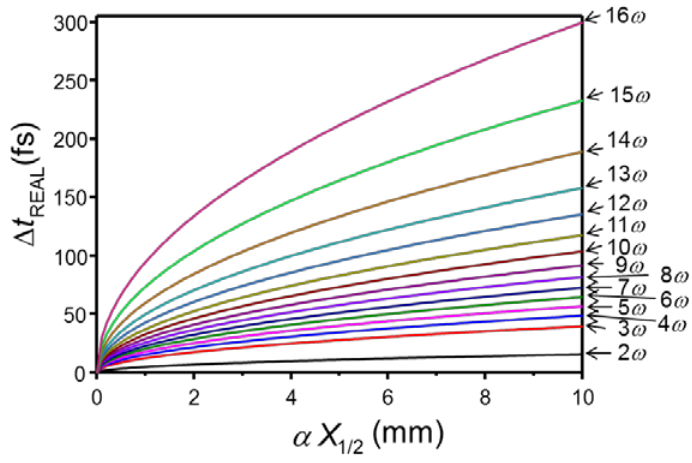
Figure 2. Calculated dependence of the parameter, Δ t REAL , on the parameter, αX 1/2 . The laser frequency, n ω , is shown in the figure, where n and ω are the order of Raman sidebands and the Raman shift frequency of molecular hydrogen ( ω = 4155 cm −1 ), respectively. The definitions of the parameters, Δ t REAL and αX 1/2 , are given in the text.